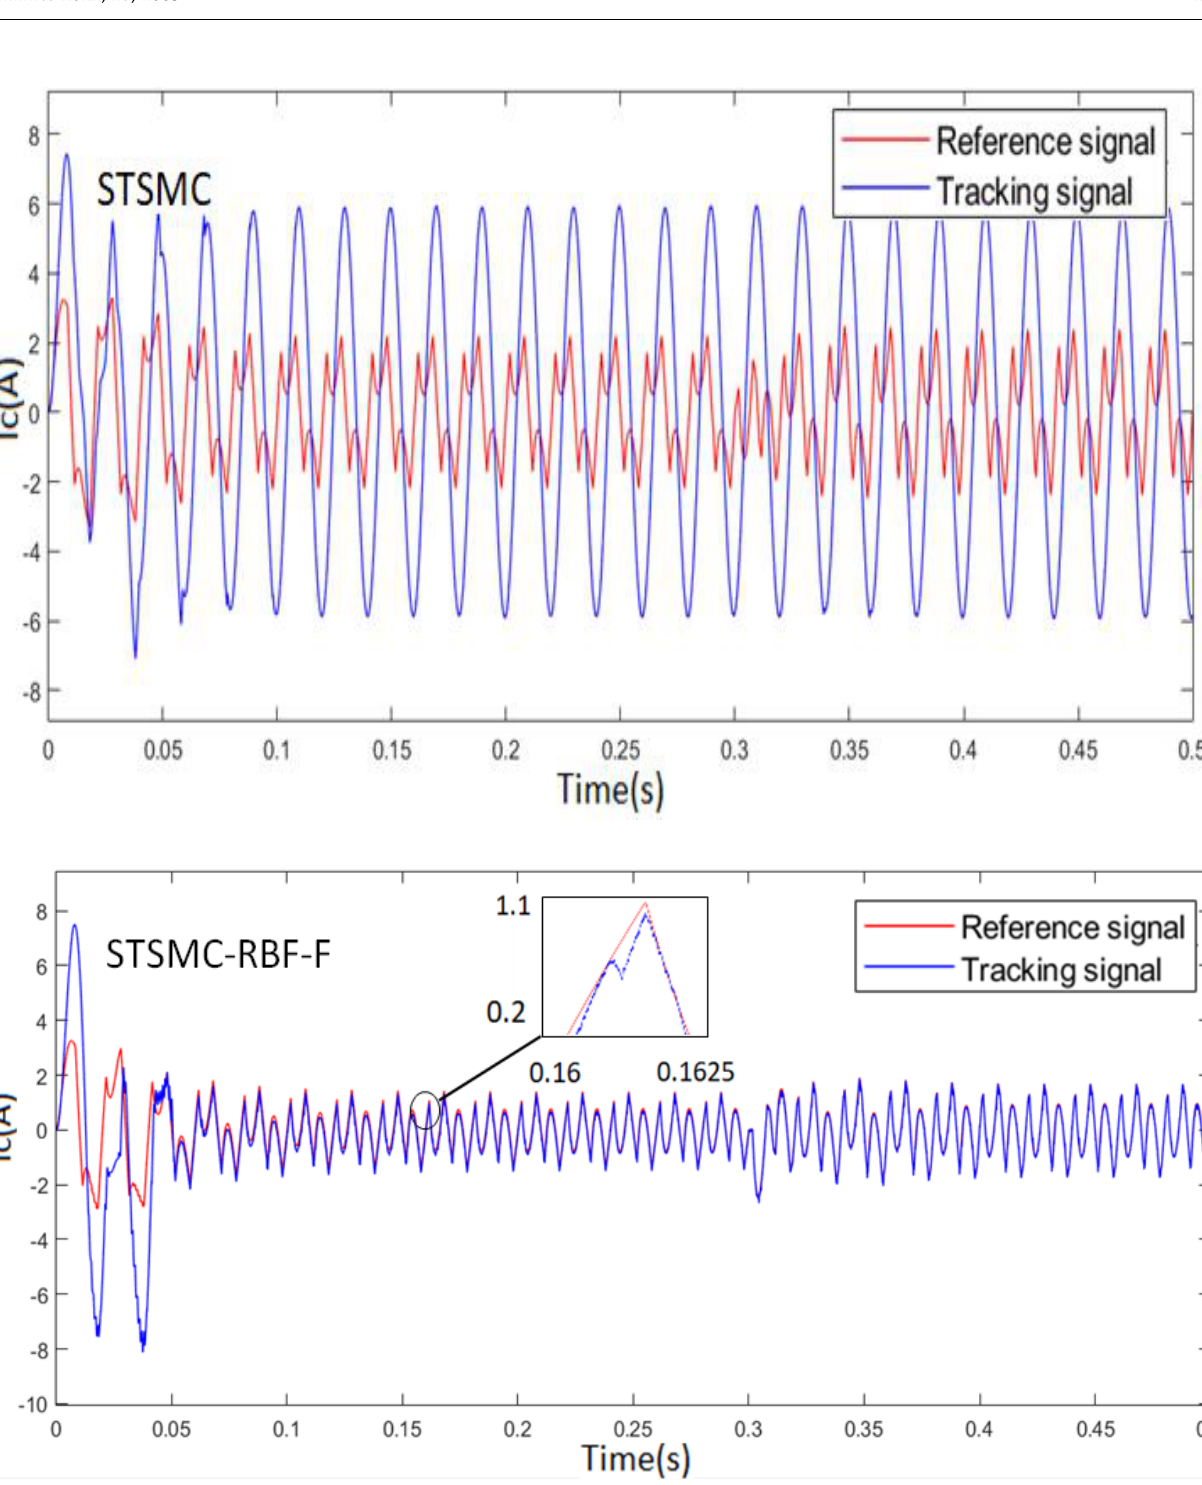
Figure 7. Comparison of tracking curve.